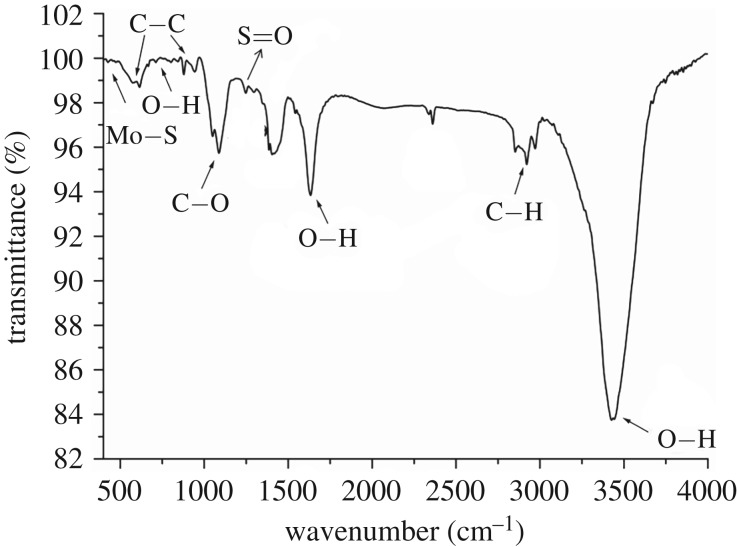
The FTIR spectrum of the PEG@MoS2 composites.